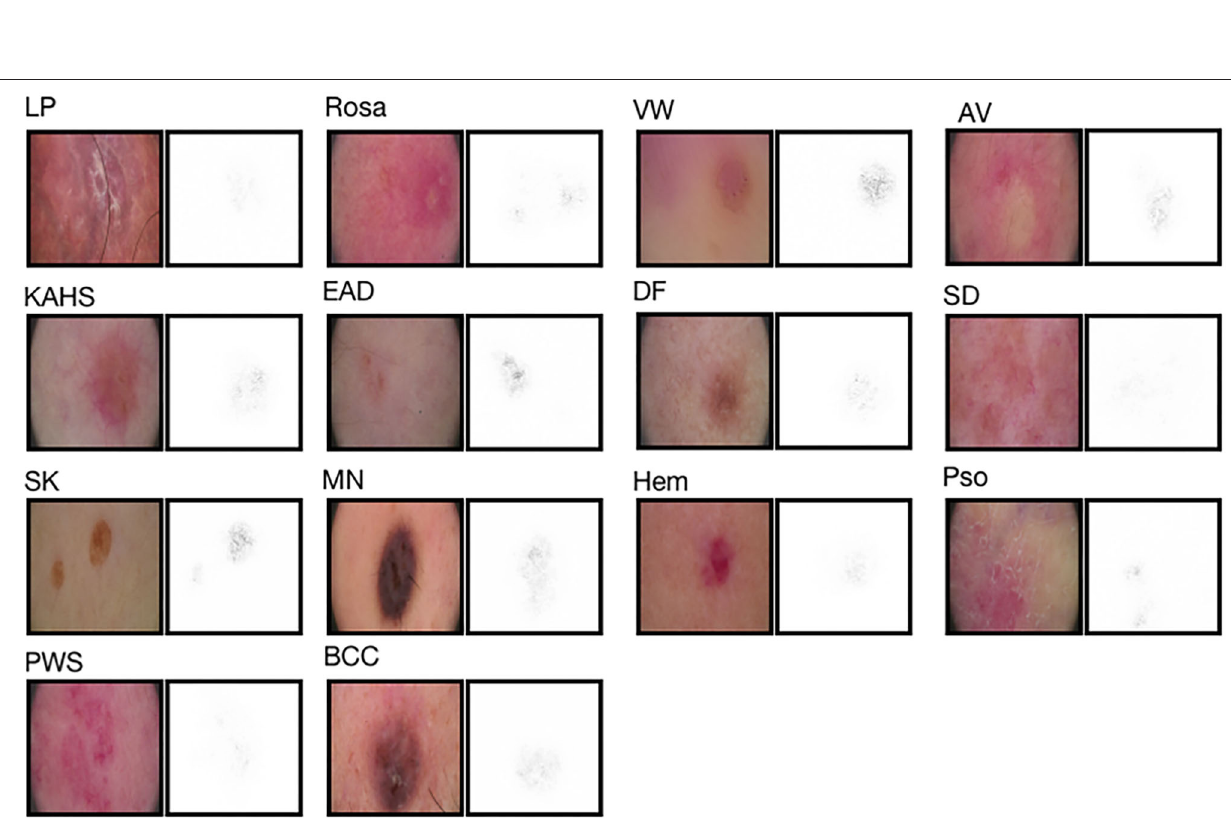
Frontiers in Medicine |